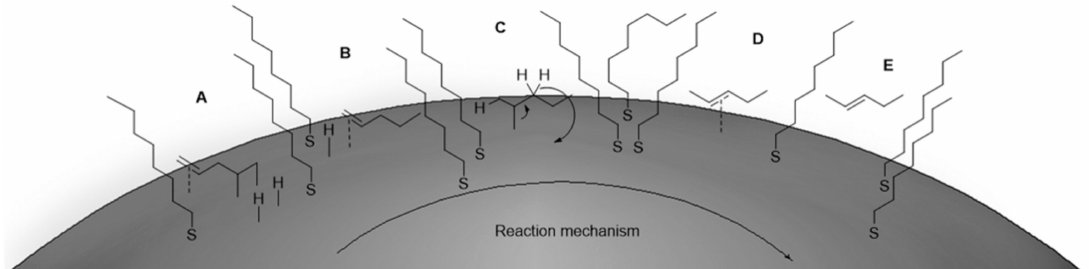
Figure 4. Proposed mechanism for the catalytic conversion of penta-1,4-diene by alkanethiolate-capped PdNP (5 mol % Pd/substrate, 0.5 mmol substrate in 2.5 mL CDCl 3 , 1 atm H 2 ). Reproduced from Ref. [74] with permission from the Royal Society of Chemistry,